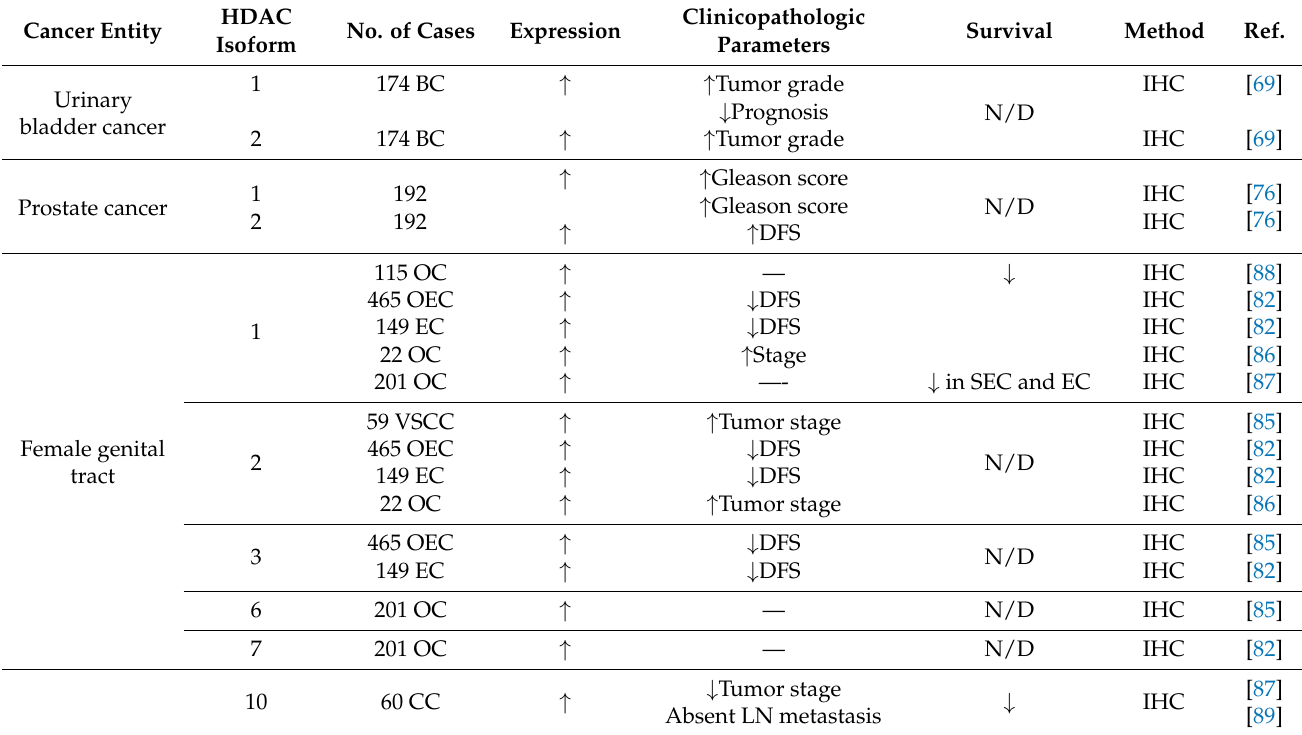
Table 5. Association of different HDAC isoforms expression in urogenital tract tumors and their correlation with clinico- pathological parameters and patients’